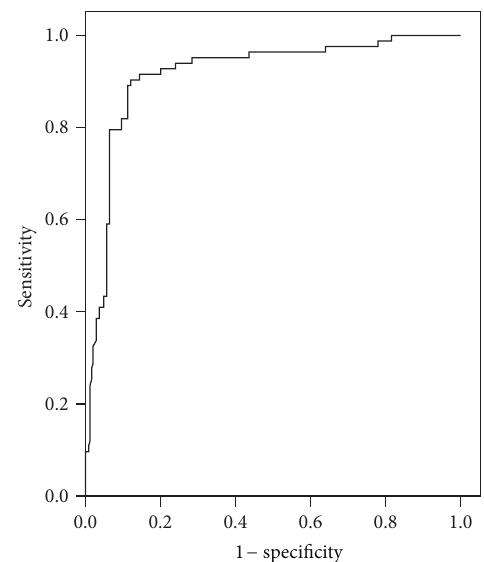
Figure 4: Receiver operating characteristic (ROC) curve of fms- like tyrosine kinase (sFlt-1) in the prediction of preeclampsia. Area under the curve (AUC) = 0.891 (95% CI: 0.835–0.947; 𝑃 < 0.0001 ).